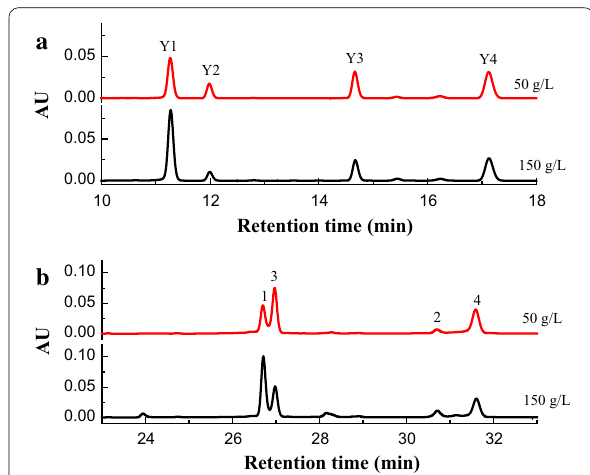
Fig. 3 HPLC-PDA chromatogram of pigments fermented under different IGCs. a Extracellular pigments. b Intracellular pigments. Y1, Y2, Y3 and Y4 are four extracellular water-soluble yellow pigments. 1 monascin, 2 ankaflavin, 3 rubropunctation, 4 monascorubrin